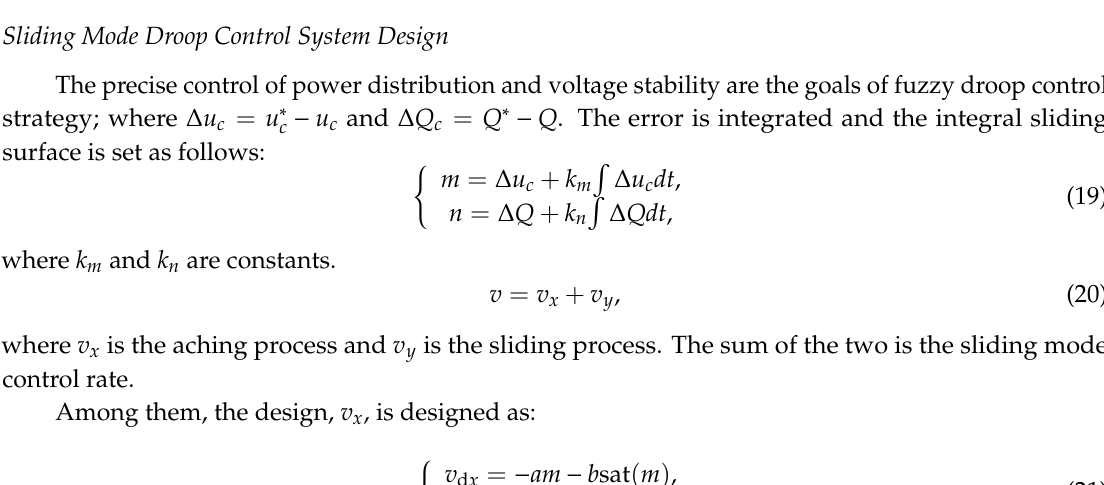
Figure 9. Surface map of